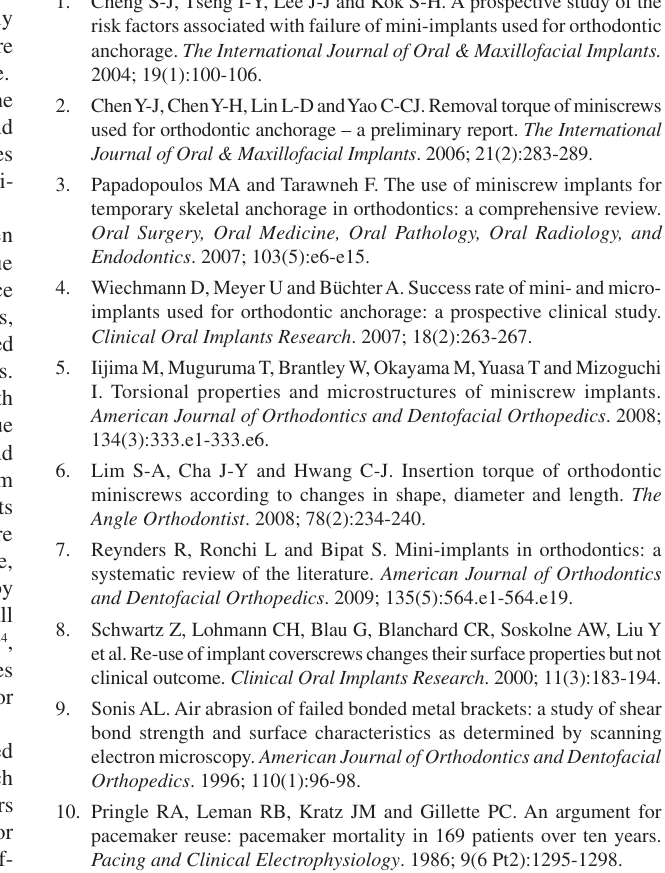
R 0.117 0.041* - *Statistically significant (P <